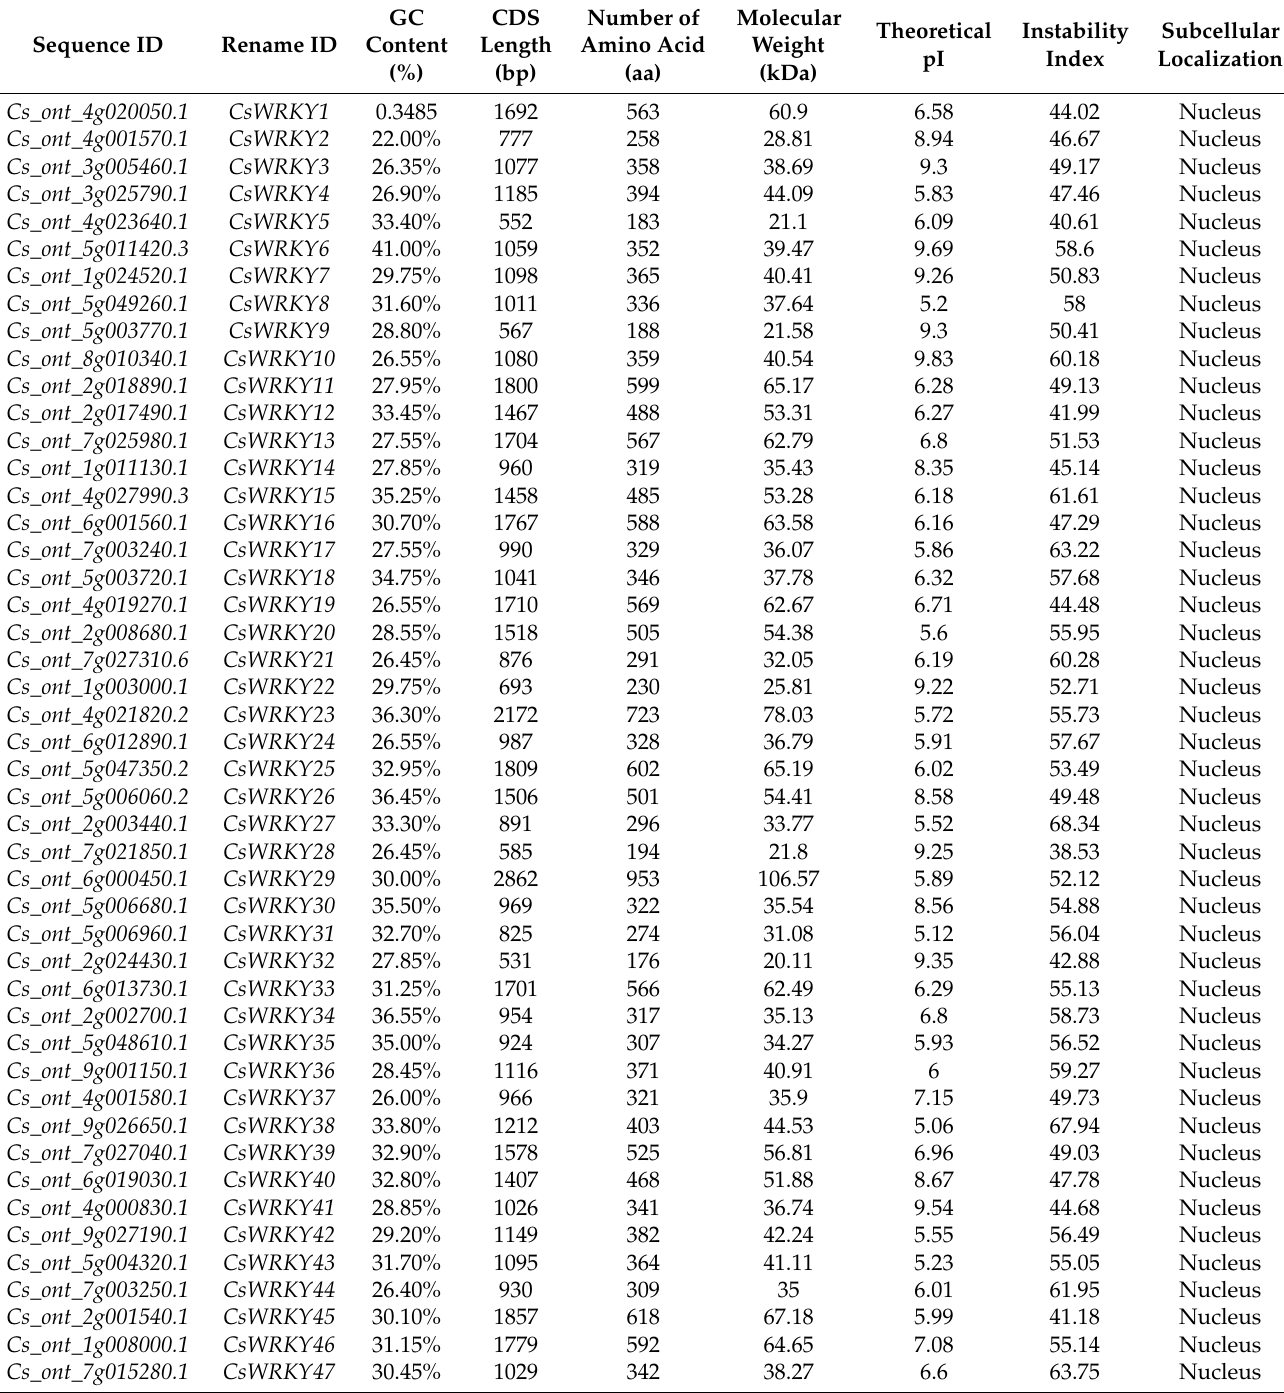
Table 1. Analysis of physicochemical properties of CsWRKY